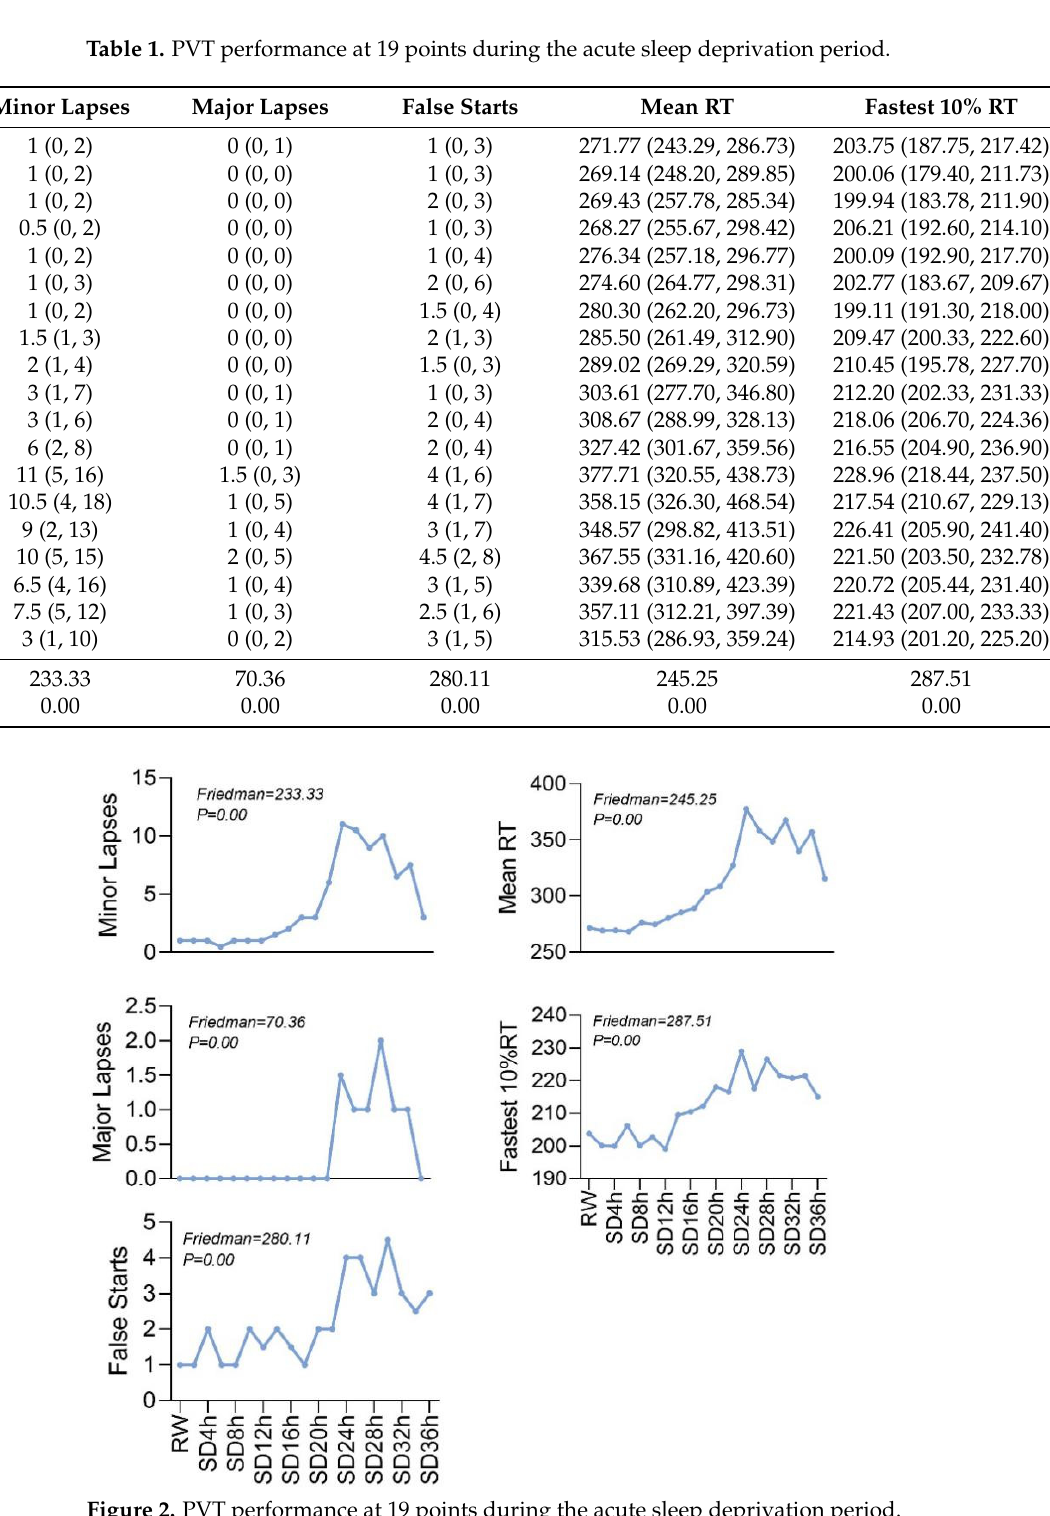
Figure 2. PVT performance at 19 points during the acute sleep deprivation period.